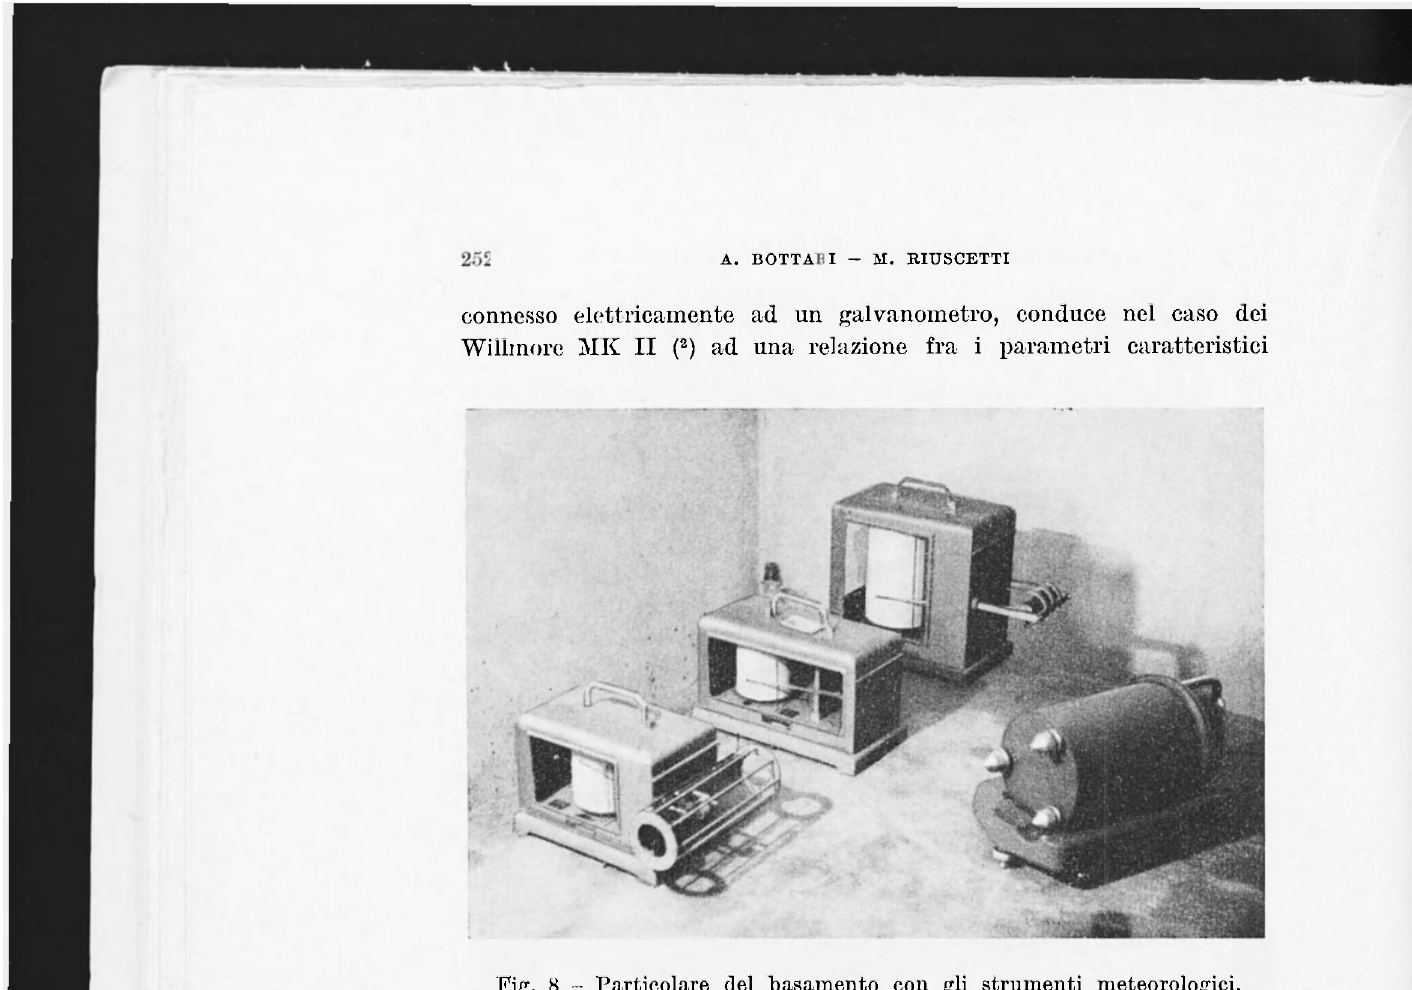
Fig. 8 - Particolare del basamento con gli strumenti